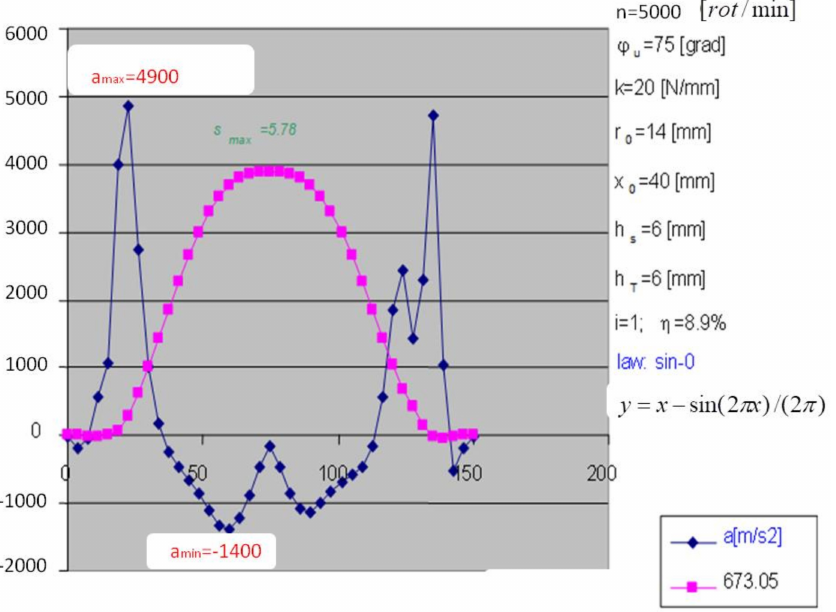
Figure 10. Dynamic analysis of the law sin, ϕ u = 75 [degree], n = 5000 [rpm], for the classic module with rotating cam and translation tracker with